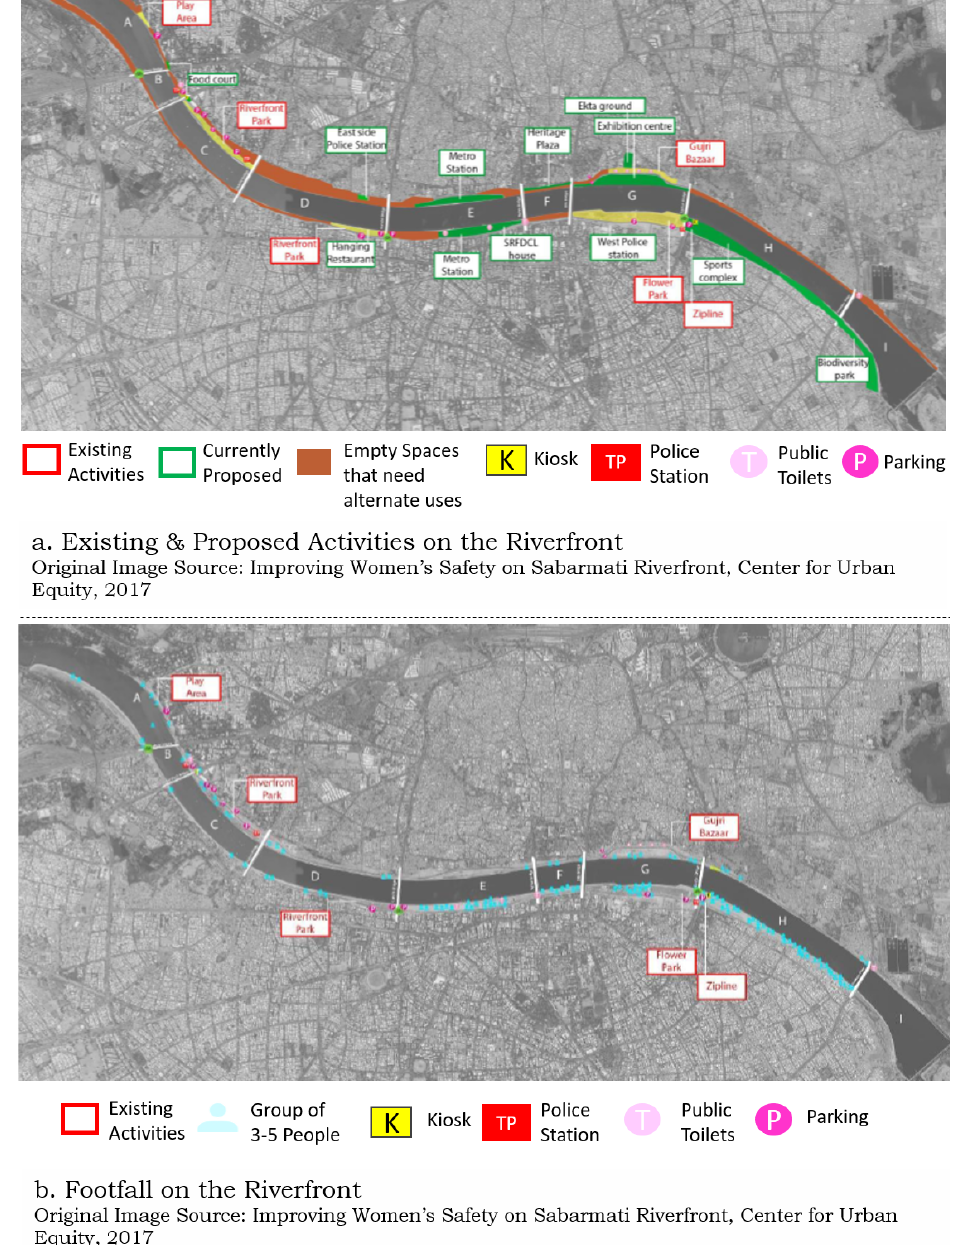
Figure 2. Activity provision and footfall on the Riverfront. poorly lit and mainly used for parking (refer to Figure